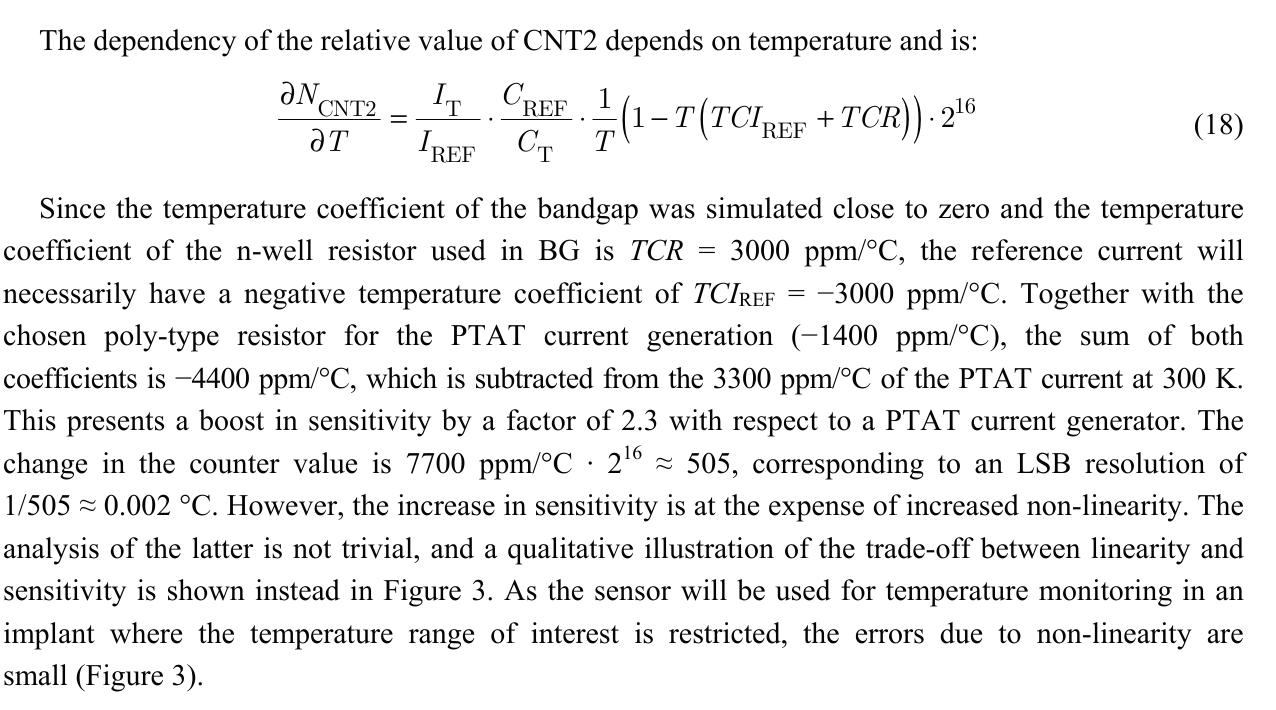
Figure 3. Qualitative illustration of the compromise between linearity and sensitivity of the ratio between PTAT and reference currents. ( a ) A reference current with a low negative temperature coefficient will result in increased overall sensor sensitivity while minimally compromising linearity; ( b ) Sensitivity can be further increased with a reference current of a higher negative temperature coefficient, at the cost of increased deviation from